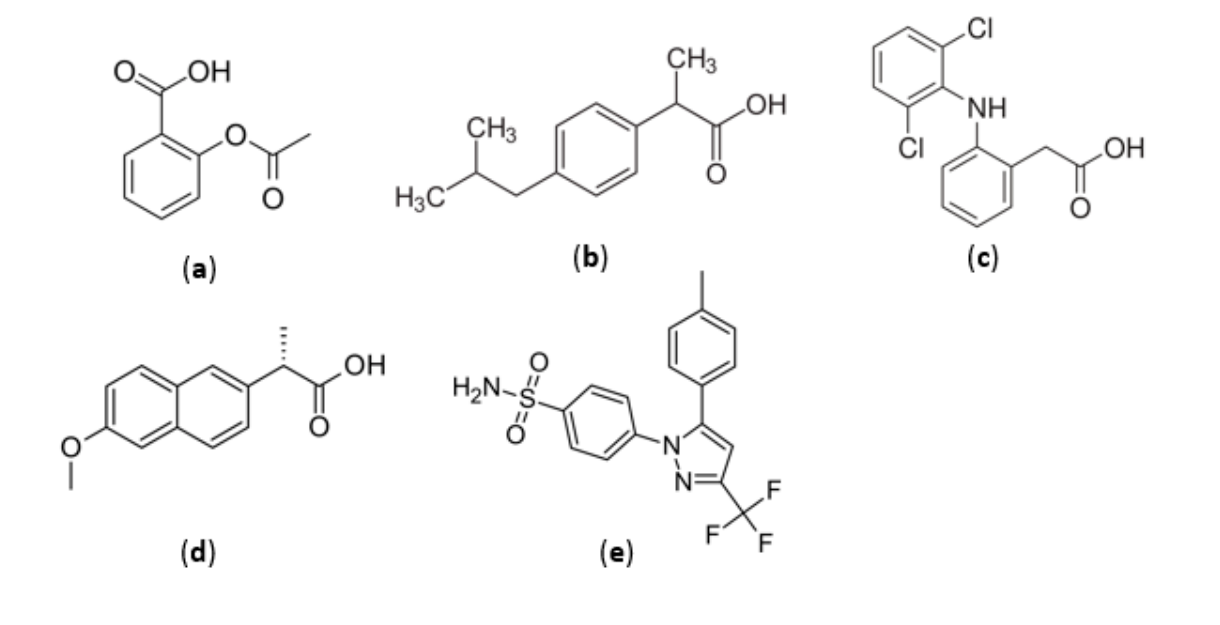
Figure 4. Chemical structures of non-steroidal anti-inflammatory agents: ( a ) aspirin, ( b ) ibuprofen, ( c ) diclofenac, ( d ) naproxen and ( e ) celecoxib.